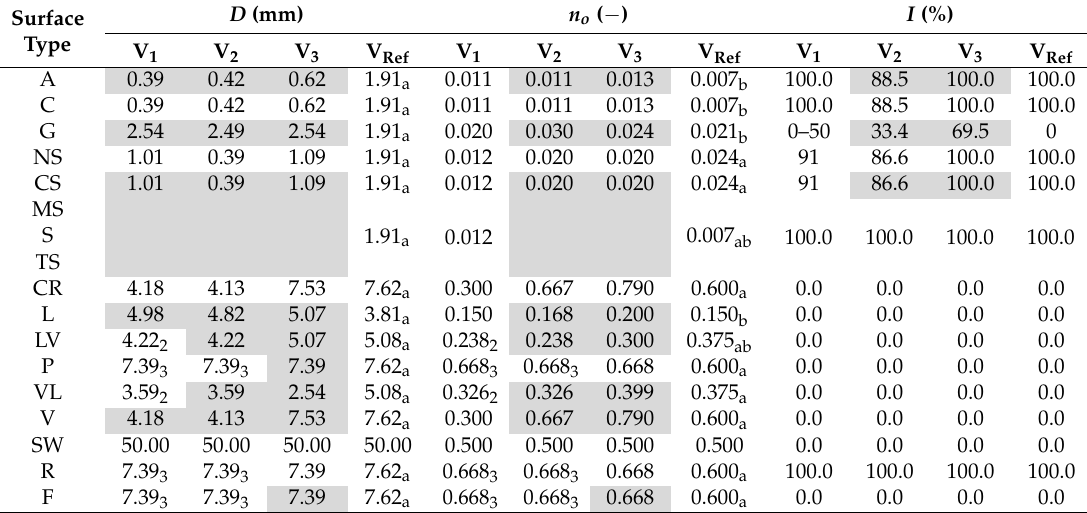
Table 3. The parameter sets V 1 , V 2 , V 3 , and V Ref for the depression storage D , the Manning’s roughness for overland flow n o , and the imperviousness I . Parameters that were calibrated for the catchment have a gray background, uncalibrated values have a white background, and the subscripts 1–3 indicate from which study catchment values were adopted if corresponding surfaces were missing. Parameter values of V Ref with subscript a were derived from Rossman [17], values with subscript b were derived from Huber and Dickinson [16], and values with subscript ab were interpolated between suggestions in Rossman [17] and Huber and Dickinson [16]. A description of the “surface type codes” is given